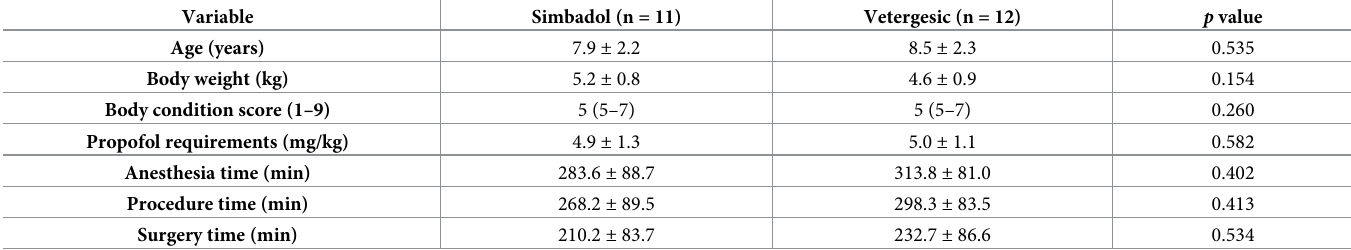
Table 2. Demographic data including age, body weight, body condition score, propofol requirements for anesthetic induction, and anesthesia, procedure and sur- gery times. Values are expressed as mean ± SD except for body condition score which is reported as median (range).